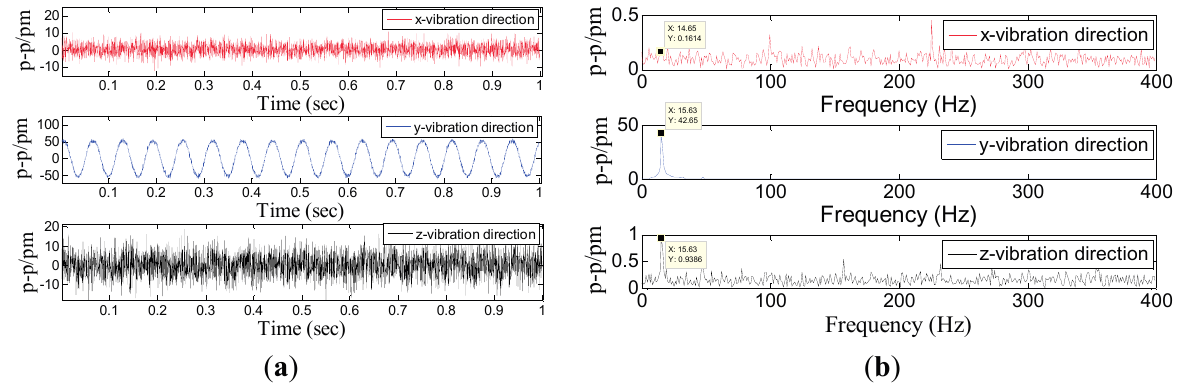
Figure 9. Time domain signal of each FBG under y -direction excitation with the acceleration — 1m/s 2 -16Hz.